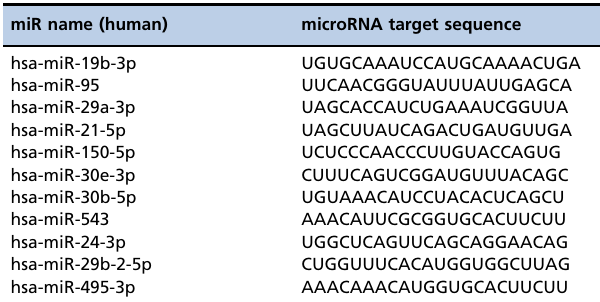
Table S3 - Ten significant upregulated miRNAs in patients with EH and T2DM.